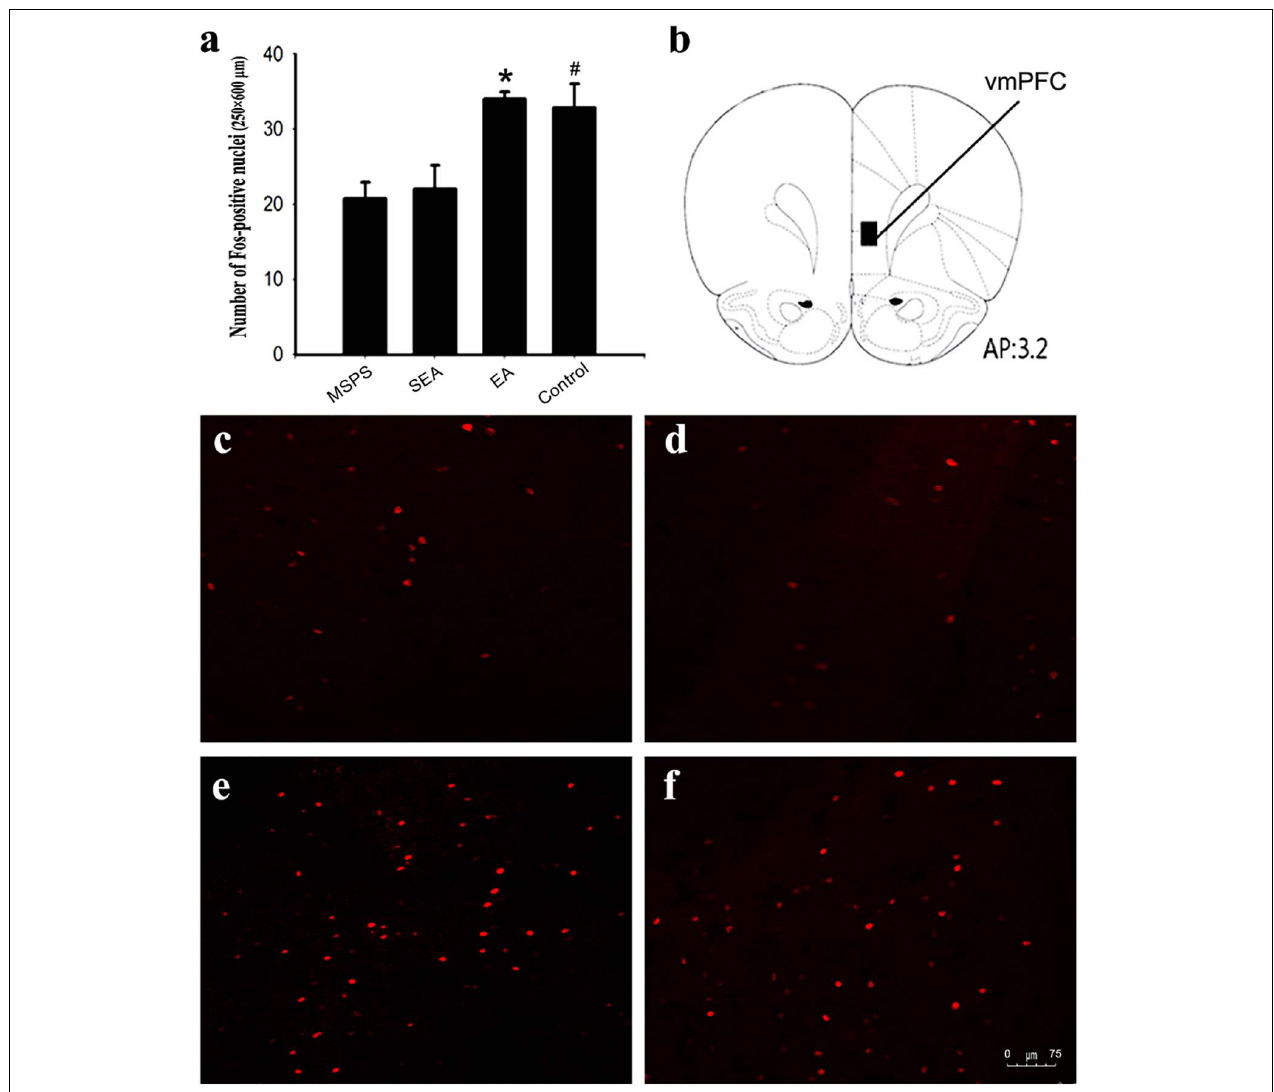
FIGURE 3 | EA treatment increases the number of Fos-positive nuclei in the vmPFC of MSPS model rats. (a) Quantitative assessment of Fos-positive nuclei in the vmPFC. Data are means ± SEM. *# P < 0.05 vs. PTSD group. (b) Schematic overview of a coronal section through the vmPFC, with a 200 µ m × 500 µ m rectangle highlighting the region of the vmPFC in which Fos-positive nuclei were counted. The number at the bottom of the schematic indicates the distance from the bregma in millimeters. This image was adapted from an atlas produced by Paxinos and Watson. (c–f) Representative coronal sections illustrating Fos staining in the vmPFC: (c) MSPS group; (d) SEA group; (e) EA group; (f) Control